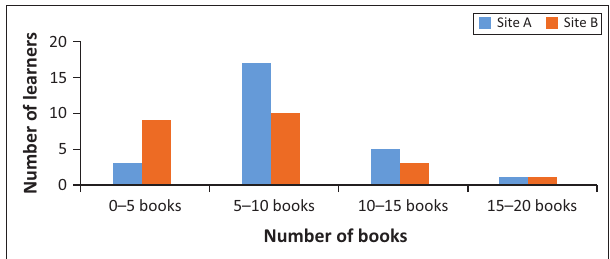
FIGURE 3: Number of books read by